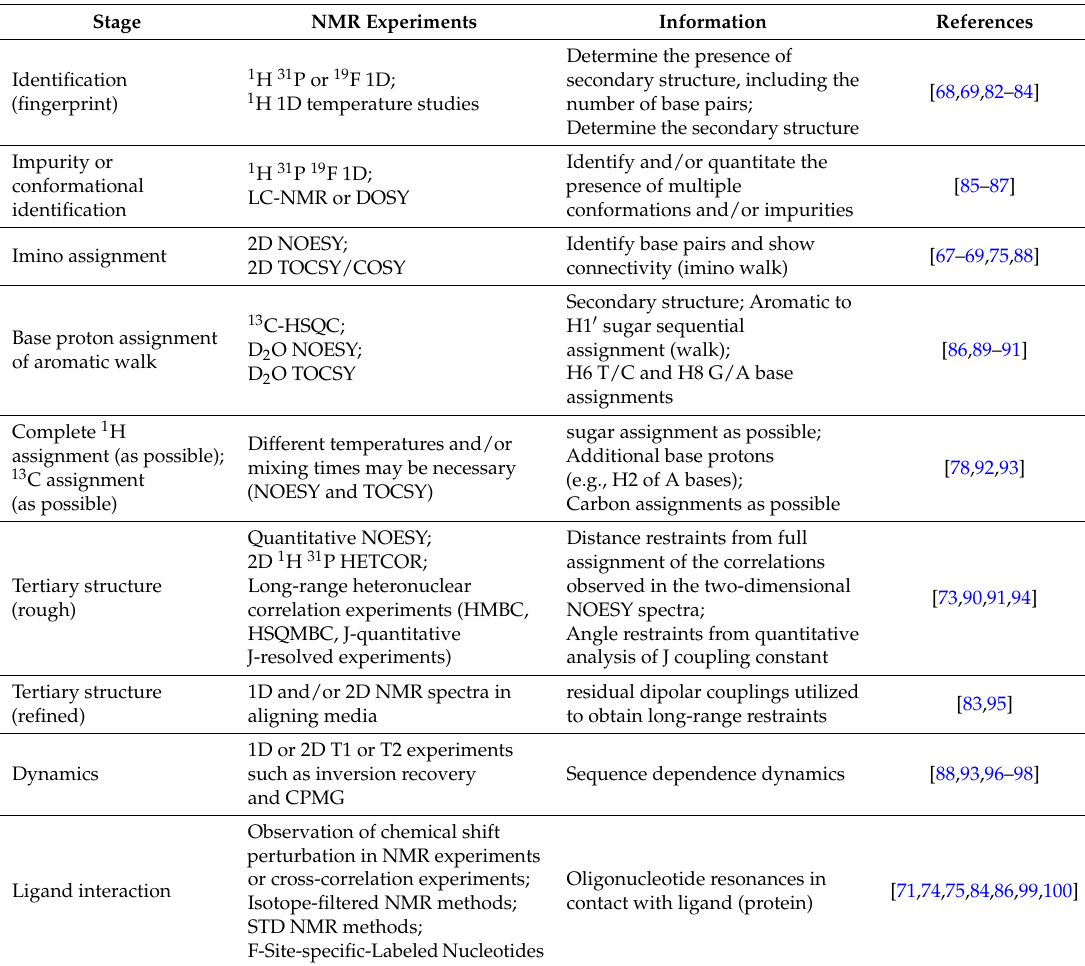
Table 2. NMR experiments used in studying the structure of oligonucleotides (Modified and updated according to the reference